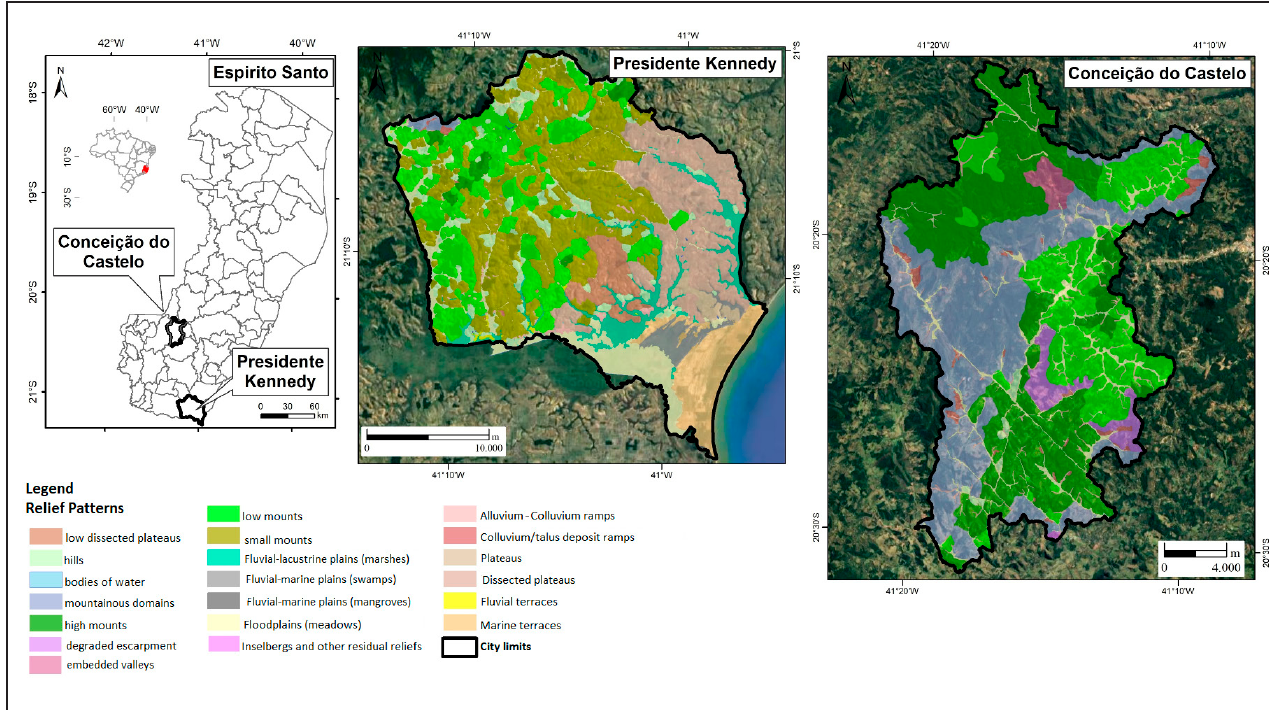
Figure 1 - Maps showing the local and relief patterns of the study area: the Presidente Kennedy and Conceição do Castelo municipalities, Espírito Santo state,